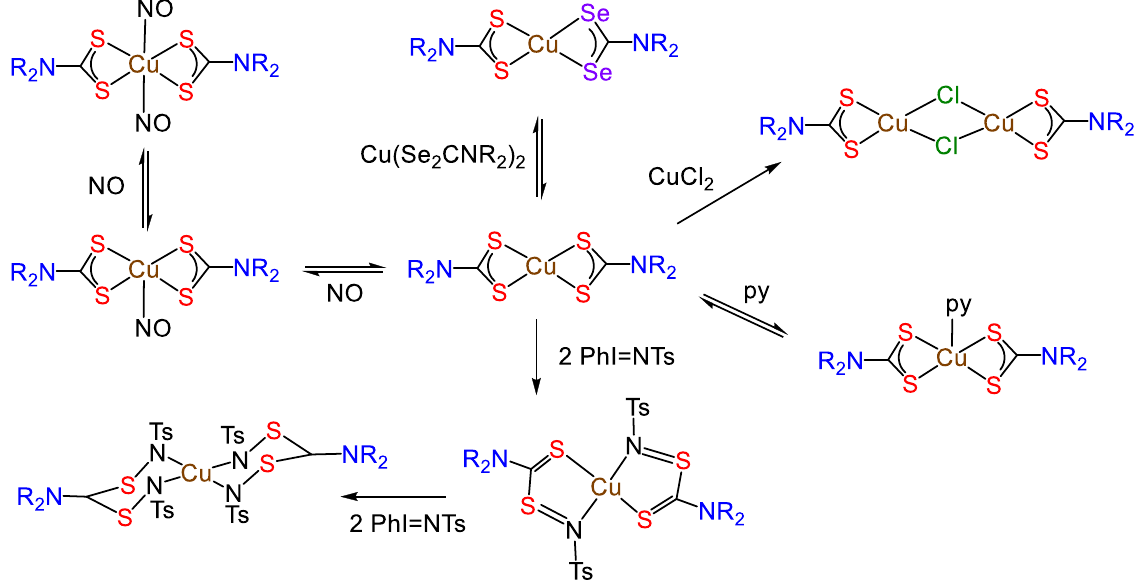
Figure 8. Selected reactions of [Cu(S 2 CNR 2 ) 2 ].